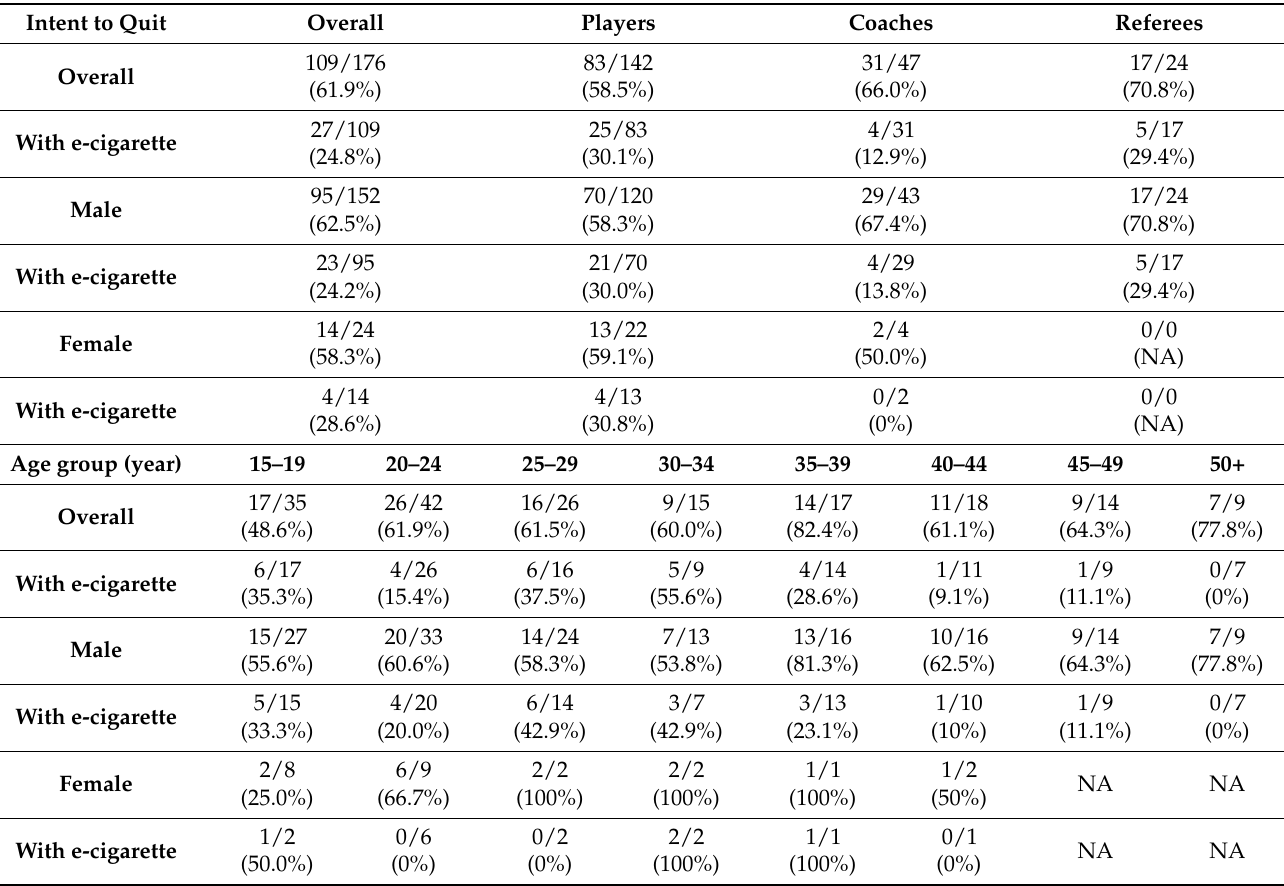
Table 3. Characteristics of individuals who intended to quit smoking {n (%)}. e-cig: electronic cigarette. Bold and shading: categories and age group. NA: not applicable.